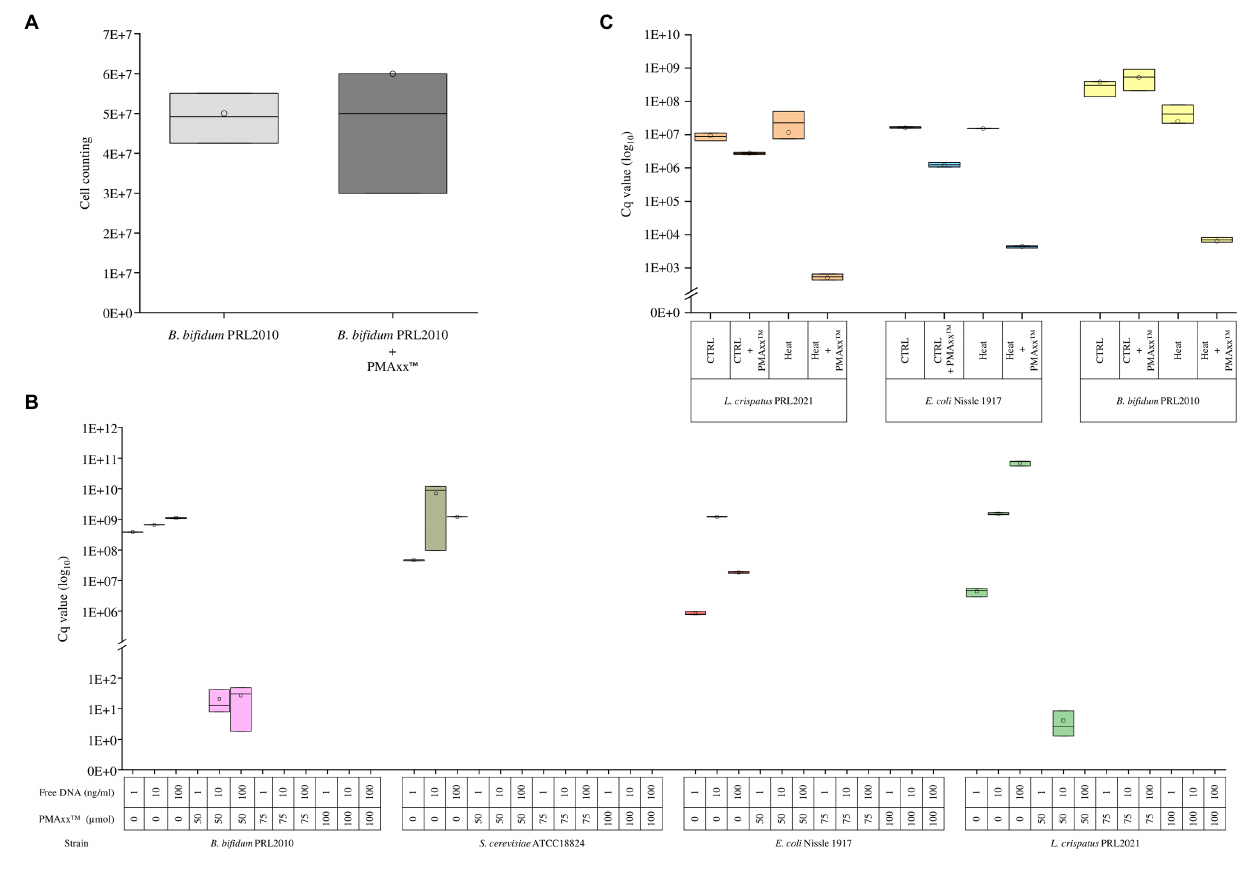
FIGURE 1 | Evaluation of the PMAxx ™ efficacy on simple bacterial communities. Panel A shows the bacterial load of B. bifidum PRL2010 cells treated and no-treated with PMAxx ™ . In the whiskers plot, the y-axis indicates cell counting. The boxes are determined by the 25th and 75th percentiles. The whiskers are determined by the maximum and minimum values and correspond to the boxes’ extreme values. The line in the boxes represented the average, while the circle represents the median. Panel B reveals the qPCR results based on DNA extracted from B. bifidum PRL2010, L. crispatus PRL2021, E. coli Nissle 1917, and S. cerevisiae ATCC18824, respectively. Each strain was evaluated with a different DNA volume and with or without PMAxx ™ treatment. In the whiskers plot, the y-axis indicates the Cq value. The boxes are determined by the 25th and 75th percentiles. The whiskers are determined by the maximum and minimum values and correspond to the boxes’ extreme values. The line in the boxes represented the average, while the circle represents the median. Panel C reports the qPCR results performed on B. bifidum PRL2010, L. crispatus PRL2021, and E. coli Nissle 1917, respectively. Each strain was treated and not treated with heat and treated and not treated with PMAxx ™ . In the whiskers plot, the y-axis indicates the Cq value. The boxes are determined by the 25th and 75th percentiles. The whiskers are determined by the maximum and minimum values and correspond to the boxes’ extreme values. The line in the boxes represented the average, while the circle represents the